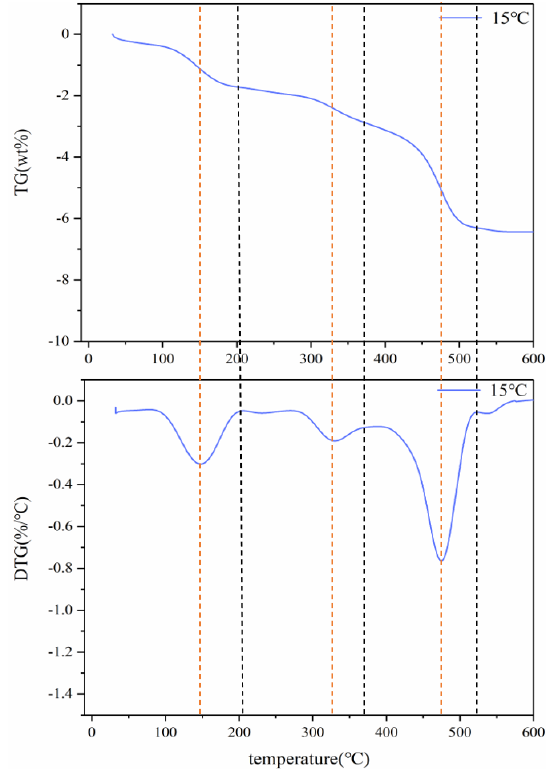
Figure 1. Thermogravimetric (TG) curves of battery materials at 15 °C.